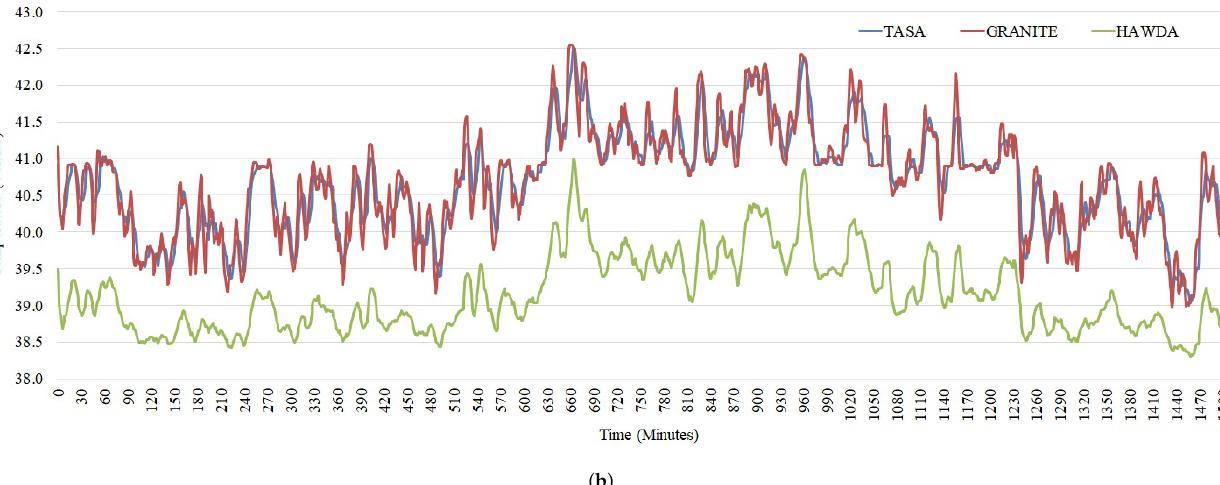
Figure 4. Peak outlet temperature from all the servers for a 25 h simulation running Alibaba cloud workload: ( a ) before server relocation, and ( b ) after server